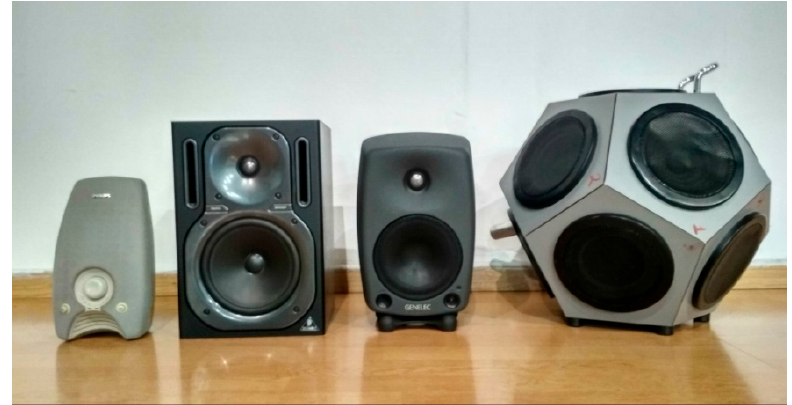
Figure 2. The common directional loudspeakers and the dodecahedron speaker that were used in this study (from left to right: Philips PCA220SD/EU, Behringer Truth B2031A, Genelec 8030B, 01 dB-Stell DO12).